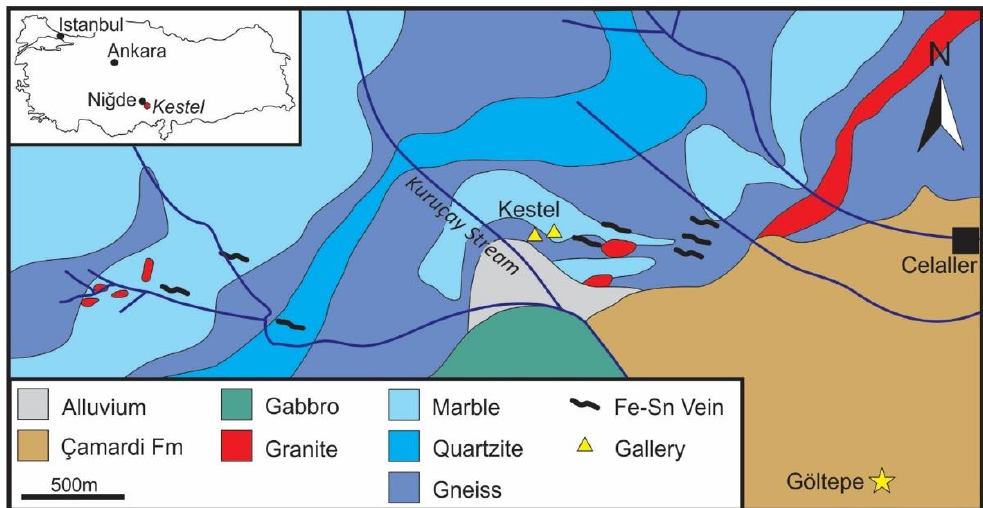
Figure 1. Local geology of the Kestel Mine [12].